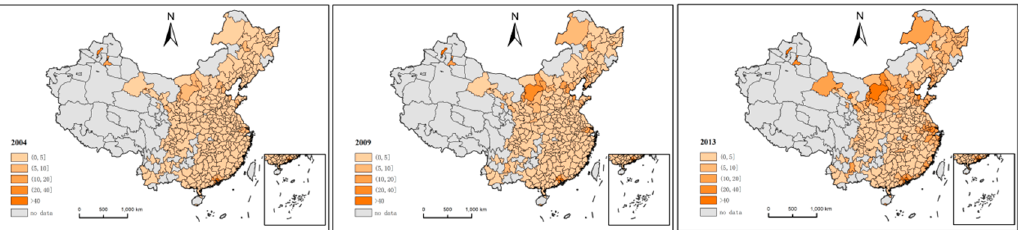
Figure 1. Spatiotemporal distribution of nighttime lighting density.